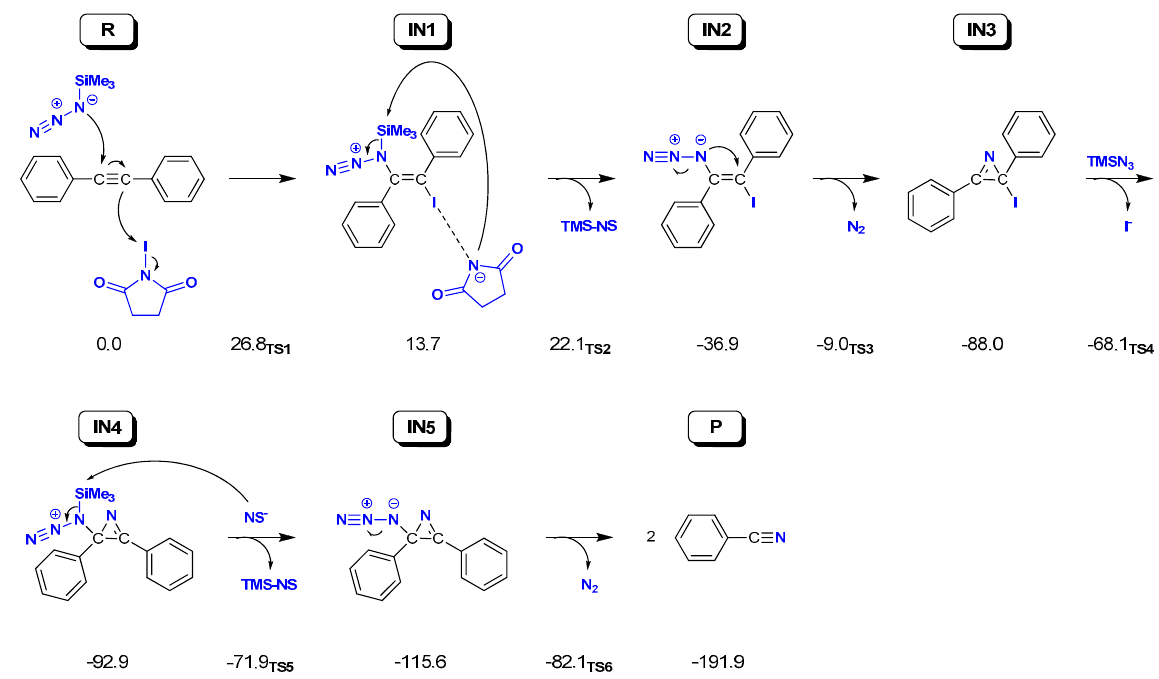
Figure 2. Reaction mechanism for the conversion of diphenylacetylene 1 to benzonitrile with N -iodosuccinimide (NIS) as an oxidant and trimethylsilyl azide (TMSN 3 ) as a nitrogen source. Relative Gibbs free energies (in kcal mol –1 ) correspond to the MeCN solution. TS and IN denote transition states and intermediates, while R and P stand for reactants and products. Graphical representation of the reaction profile is given as Figure S1.